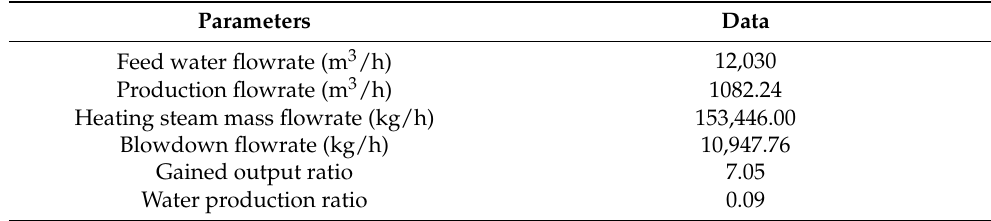
Table 3. Water production of the OT-MSF system.